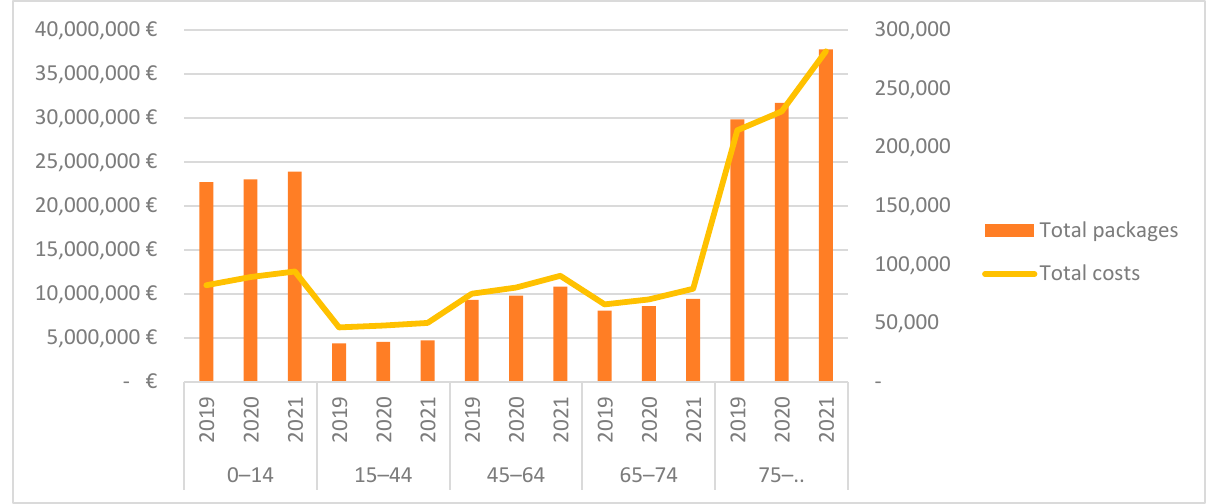
Figure 1. Number of total packs consumed and total expenditure from January 2019 to December 2021 in the Community of Madrid by age group.